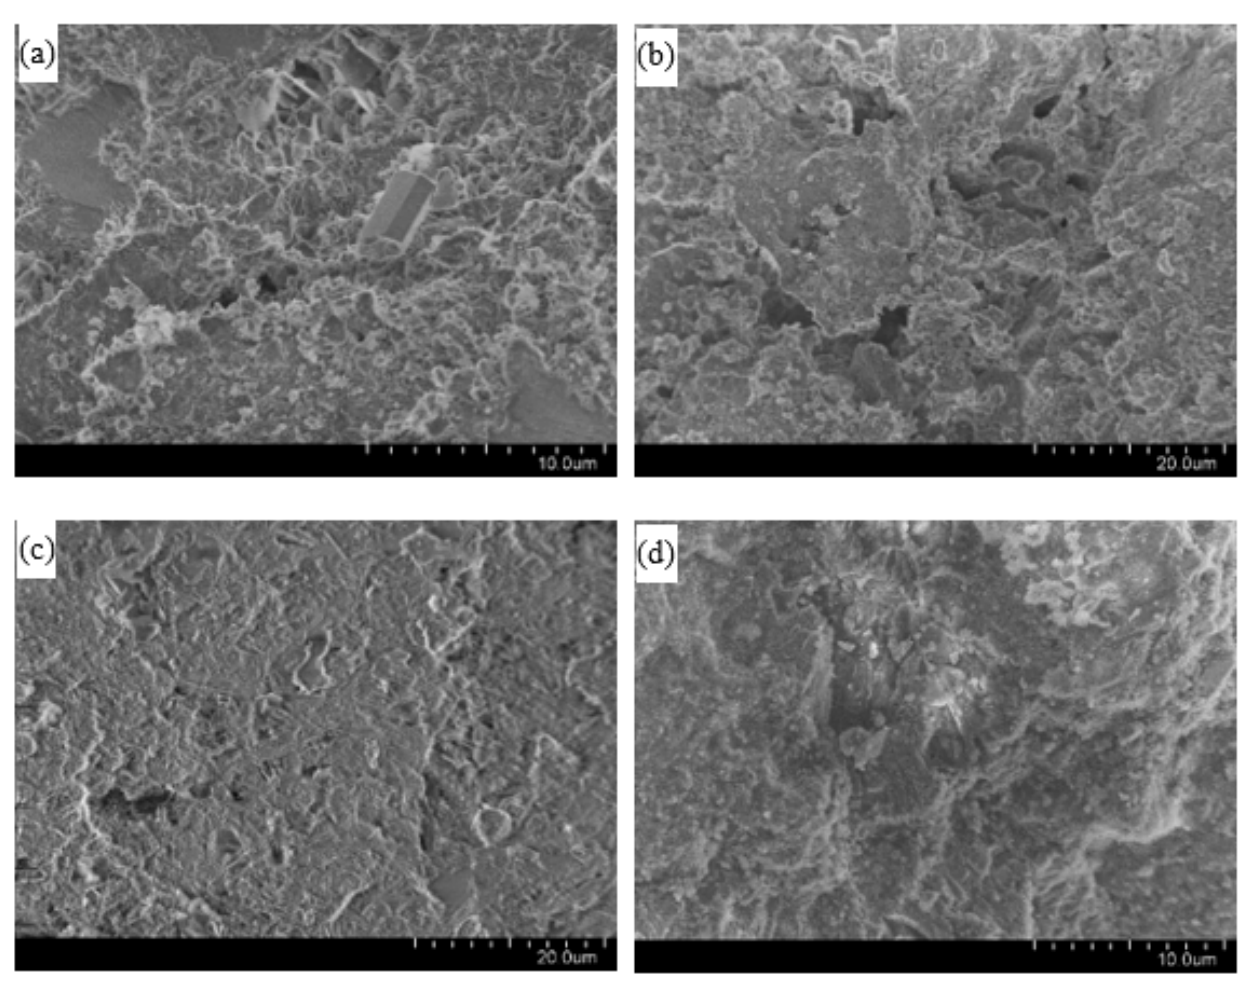
Figure 10. Micromorphology of cement paste ( a ): uncorroded S1; ( b ): corroded S1; ( c ): uncorroded S5; ( d ): corroded S5.